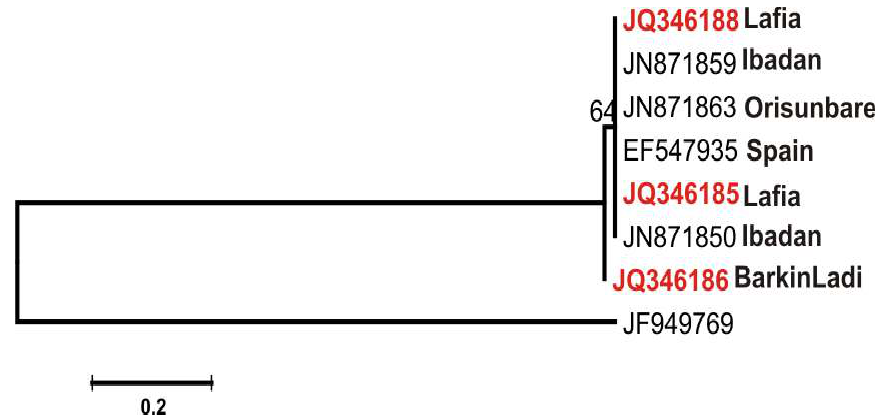
Figure-2. Neighbour-joining tree of 1000 replicates with Kimura 2 parameters from htpB gene sequences for 3 characterized C. burnetii isolates (highlighted in red) from North Central Nigeria. The tree illustrates the phylo- genetic placement of C. burnetii detected in A. variegatum ticks from 2 states in North central Nigeria and those in ticks from South west Nigeria and